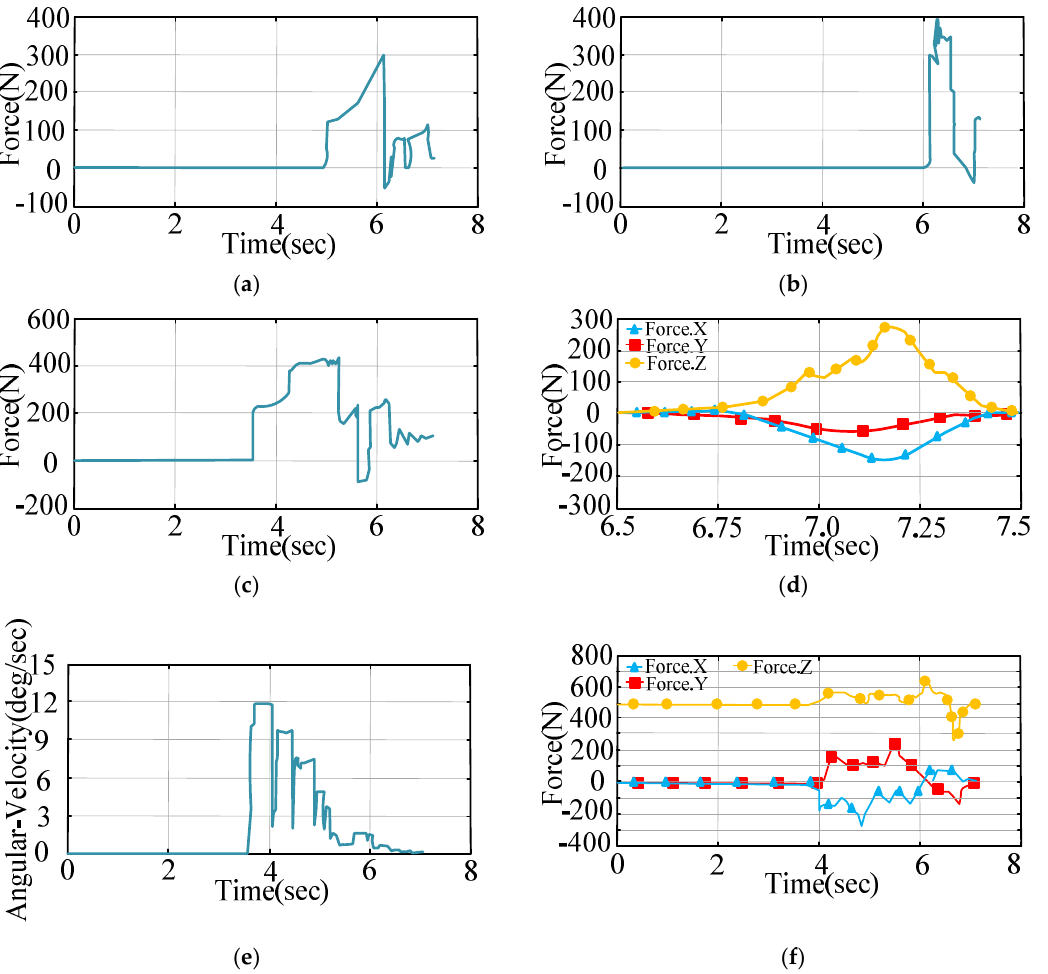
Figure 9. Curves of corresponding quantities under the oblique impact ( a ) for locking jaw 1; ( b ) for locking jaw 2; ( c ) for locking jaw 3 ( d ) between the passive docking mechanism and the matching surface; ( e ) showing the angular velocity of the spherical joint; ( f ) spherical joint.